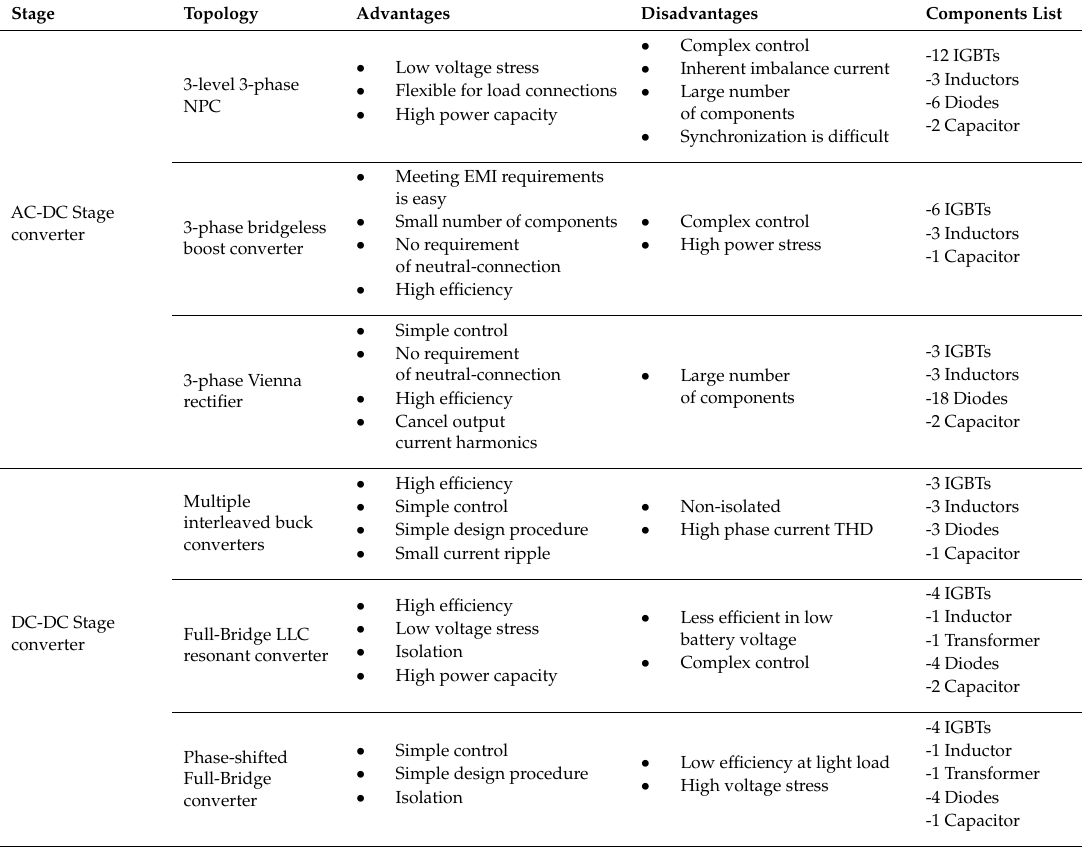
Table 9. Summary of DC-DC fast charging